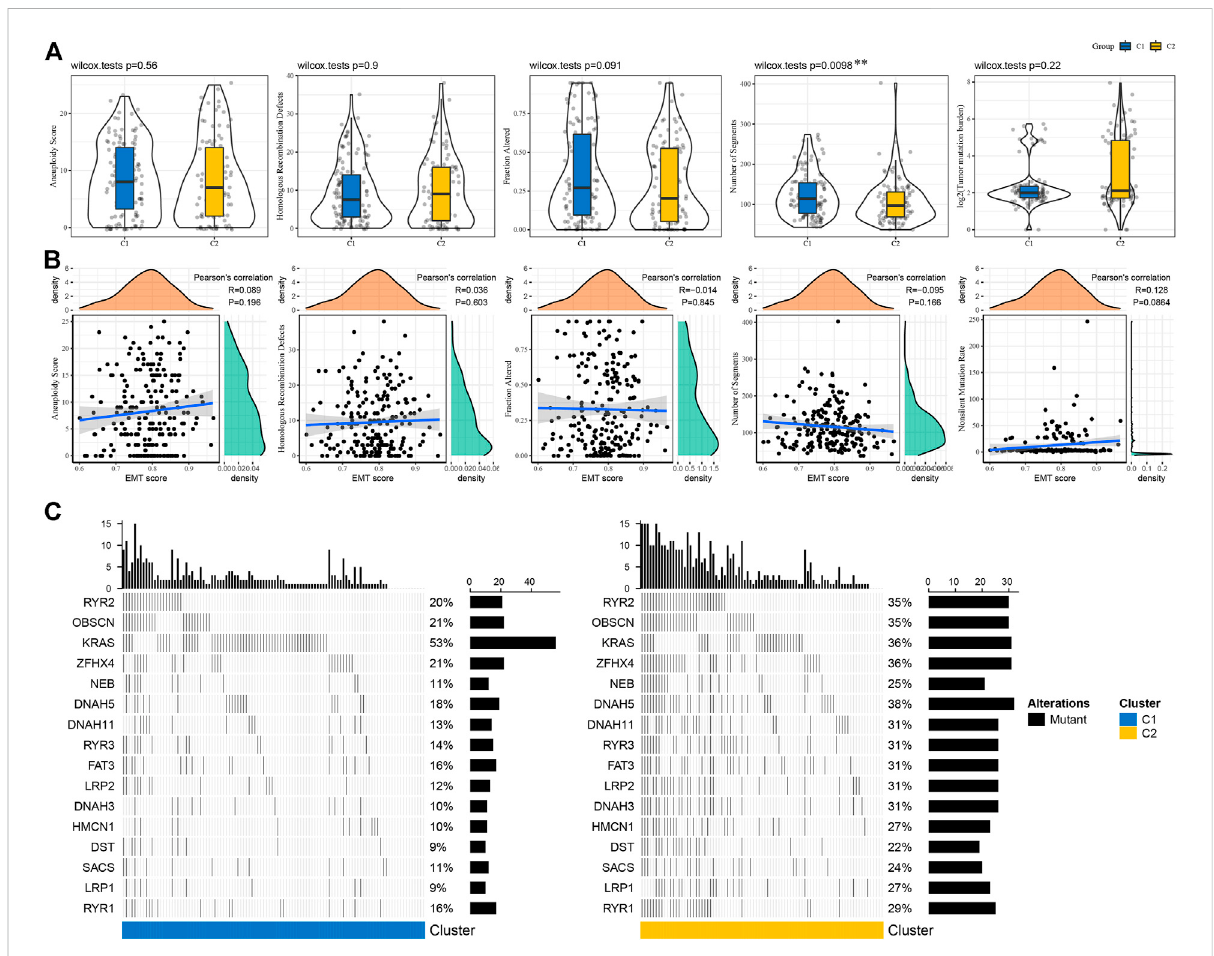
FIGURE 3 Mutation patterns of C1 and C2 subtypes (A) Genomic features of two subtypes including aneuploidy, homologous recombination defects, fraction altered, number of segments and tumor mutation burden. Wilcoxon test was performed. (B) Pearsoncorrelation analysis betweengenomic features and EMT score. (C) The top 20 signi fi cantly mutated genes in C1 and C2 subtypes. Fisher exact test was conducted. ** p <